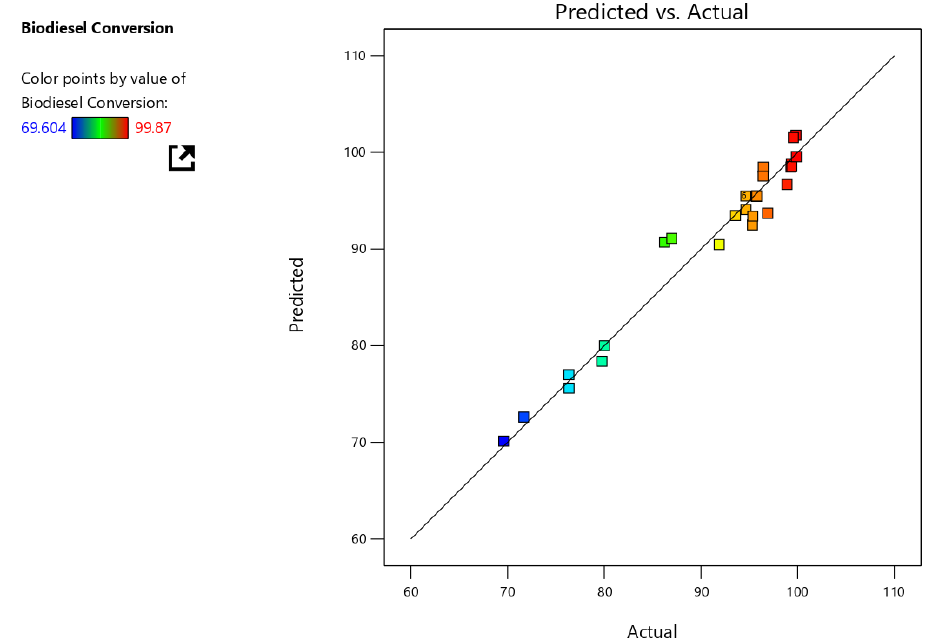
Figure 11. Relationship between biodiesel predicted yield and experimental results